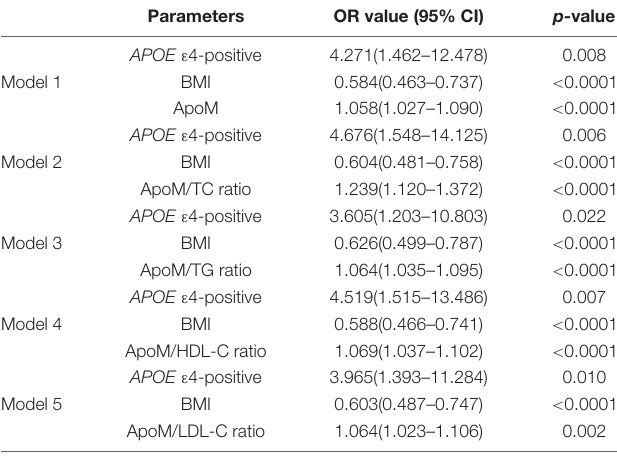
TABLE 2 | Independent factors associated with the presence of AD in binary logistic